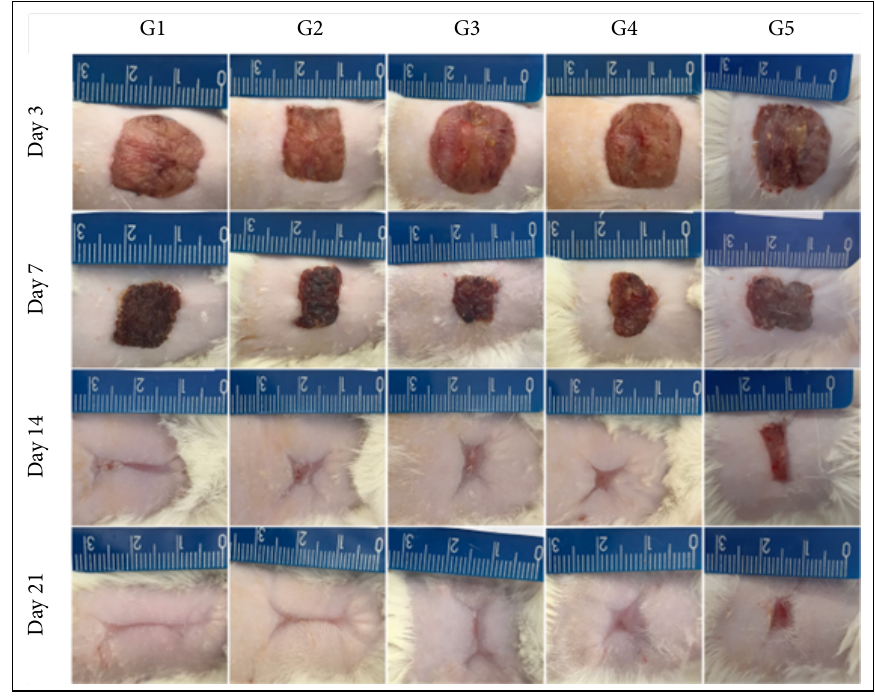
Figure 2 - Macroscopic evolution of the excisional wounds experimentally induced in rats at three, seven, 14 and 21 days after the injury